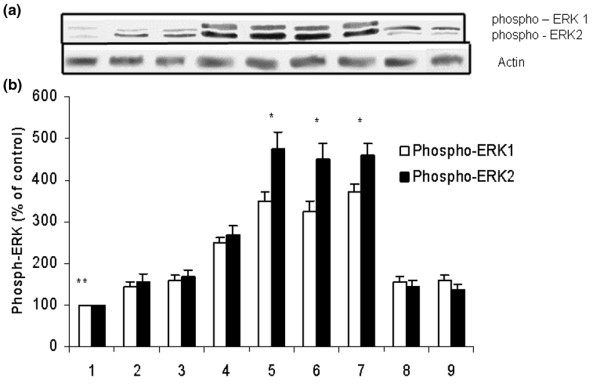
Western blot analyses of phospho-ERK1/2. (a) Representative Western blot and (b) densitometric analysis of five blots (mean ± standard error of the mean), expressed as a percentage of values for corresponding control-treated tissue samples (no ischemia or reperfusion). Groups: 1 = control, nonischemic group; 2 = ischemia/reperfusion; 3–5 = IB-MECA 50 μg/kg, 100 μg/kg, and 300 μg/kg, respectively, administered before reperfusion; 6 and 7 = MRS3558 50 μg/kg and 100 μg/kg, respectively, administered before reperfusion; 8 = MRS1191 pretreatment before MRS3558 (100 μg/kg) and beginning of reperfusion; and 9 = DMSO administration. Densitometry data presented is normalized to the intensity of actin bands. *P < 0.01 versus groups 1–4, 8, and 9. **P < 0.05 versus the other groups. DMSO, dimethyl sulfoxide; ERK, extracellular signal-regulated kinase.